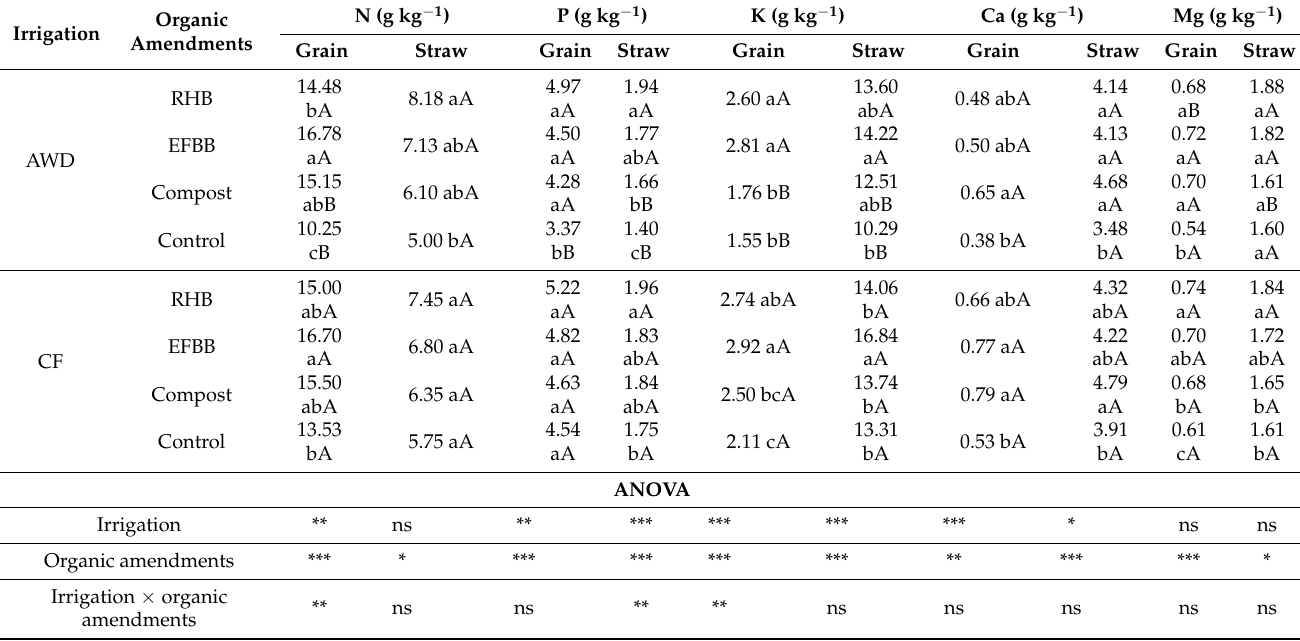
Table 3. Effect of organic amendments and irrigation management on nutrient contents in